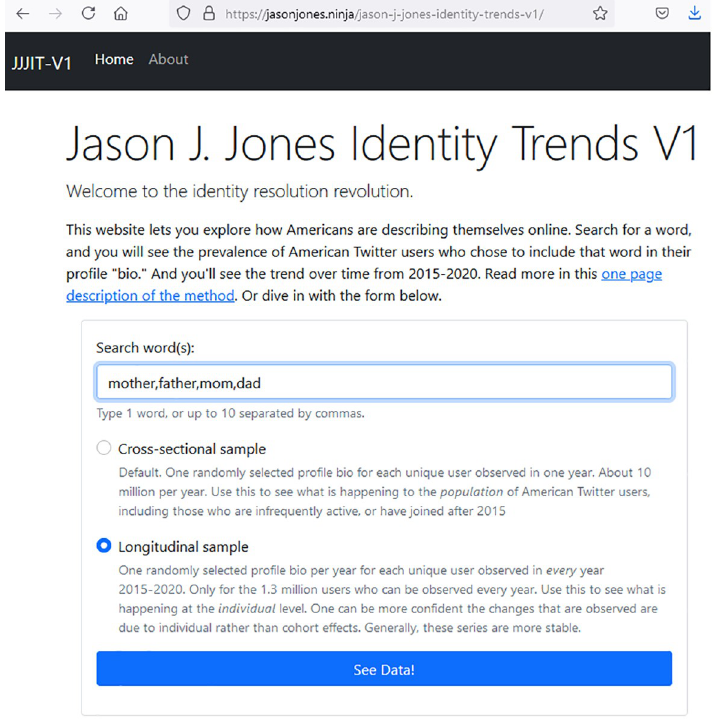
Fig 5. The interface for the web tool: Jason J. Jones Identity Trends V1. The tool is publicly accessible at https:// jasonjones.ninja/jason-j-jones-identity-trends-v1/.